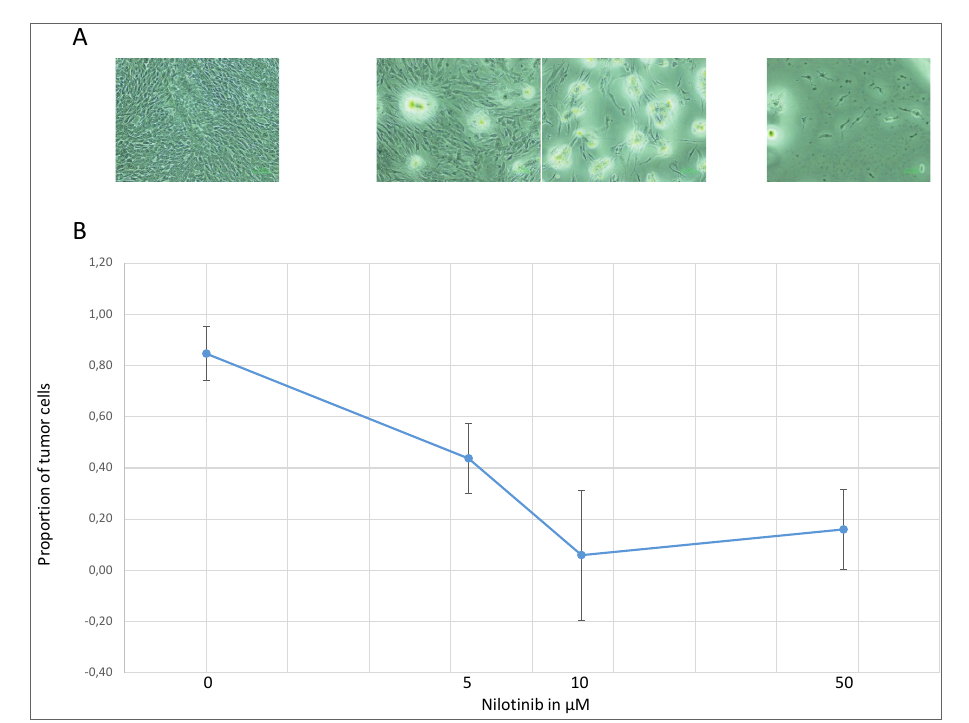
Fig. 4. Results of treatment with nilotinib for 5 days. Vital cells were visually reduced in a dose-dependent manner (A). Proportion of tumor cells, as calculated from the ratio of NF1 : RPP30 , decreased in the range of 0 to 10 μM and then slightly increased at the highest dose of 50 μM